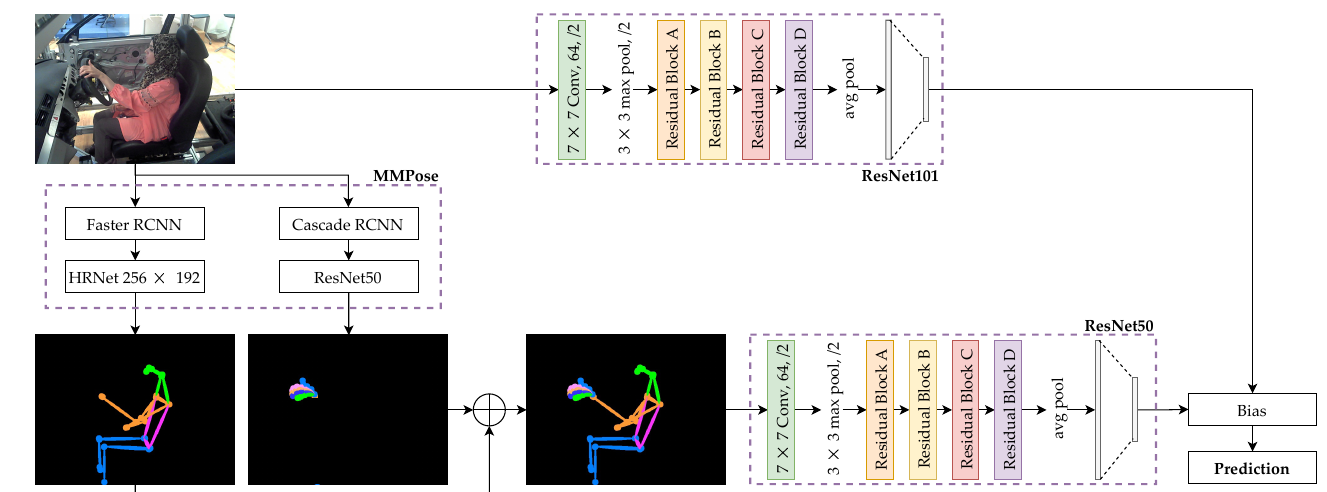
Figure 1. Proposed distraction detection through ensemble of pose estimation classification model and image classification